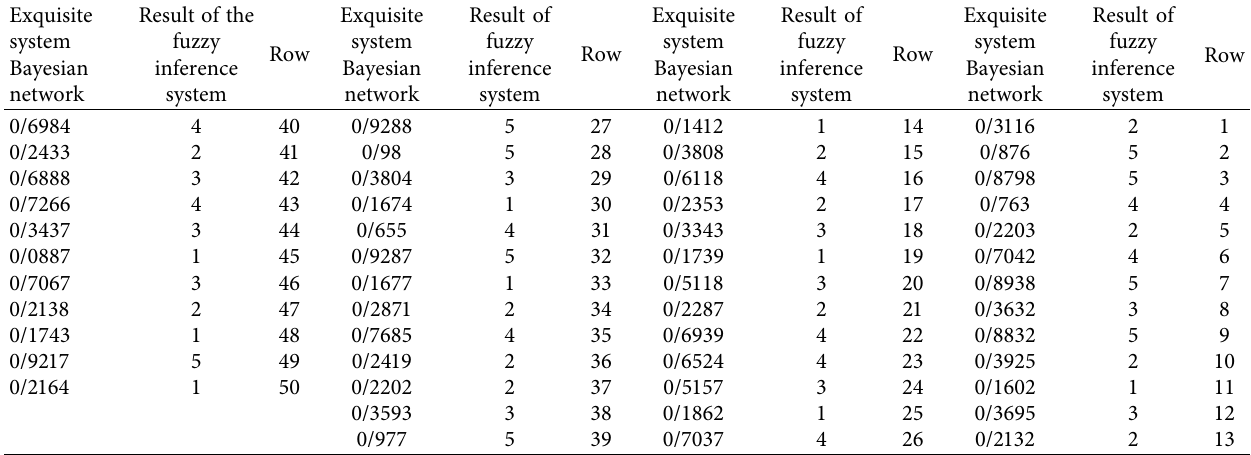
Table 10: Comparison table of the output of the two systems.